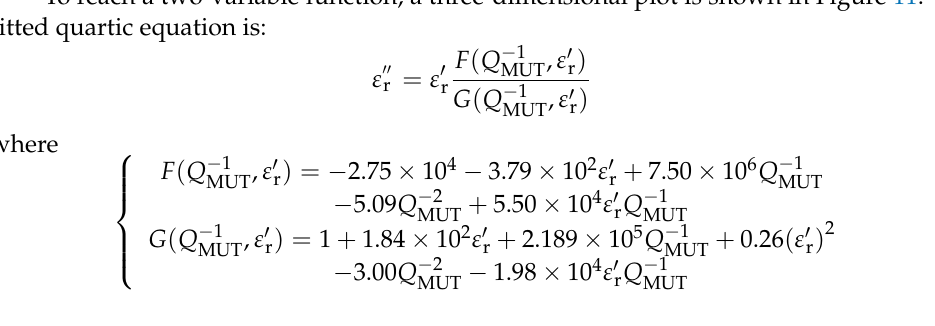
Figure 10. The relationship between Q − 1